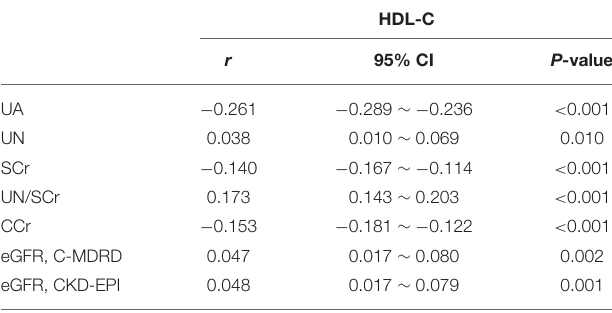
TABLE 2 | Pearson’s correlation coefficients between HDL-C and renal